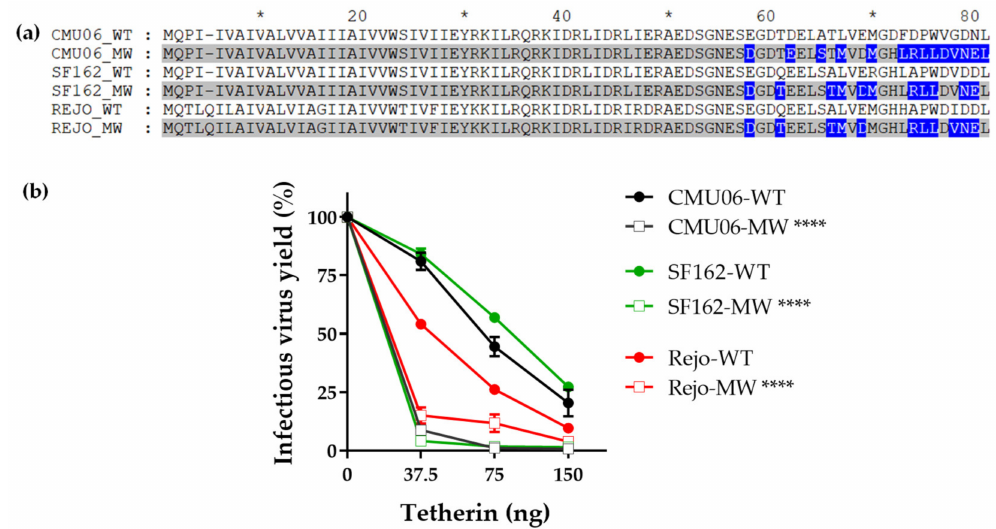
Figure 5. Effect of Vpu C-term swap on virus release in presence of tetherin. Vpu C-term MW965.26 was swapped in context of different isolates including CMU06 (acute), SF162 (chronic) and Rejo (T/F). ( a ) Alignment showing the differences in sequences. Sequences with swapped Vpu C-terminus are shaded in gray and the difference between the MW and WT sequences are highlighted in blue, gaps are indicated by trace. *, denotes blocks of 10. ( b ) HEK293T cells were co-transfected with IMCs and various amounts of plasmid expressing human tetherin. Forty-eight hours post- transfection supernatants were tested for infectious virus release by infecting TZM.bl cells as in Figure 2. ****, p < 0.0001 by ANOVA compared to their respective